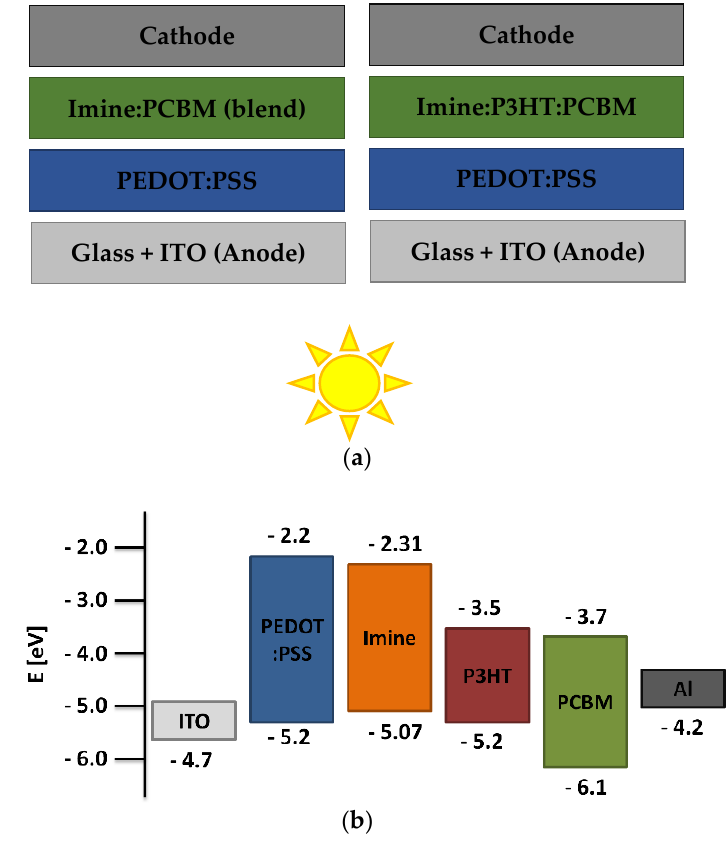
Figure 7. The structures’ scheme of prepared BHJ devices ( a ) and energy diagram with TPA-DT ( b ). Table 4. Photovoltaic parameters of fabricated BHJ PV cells.